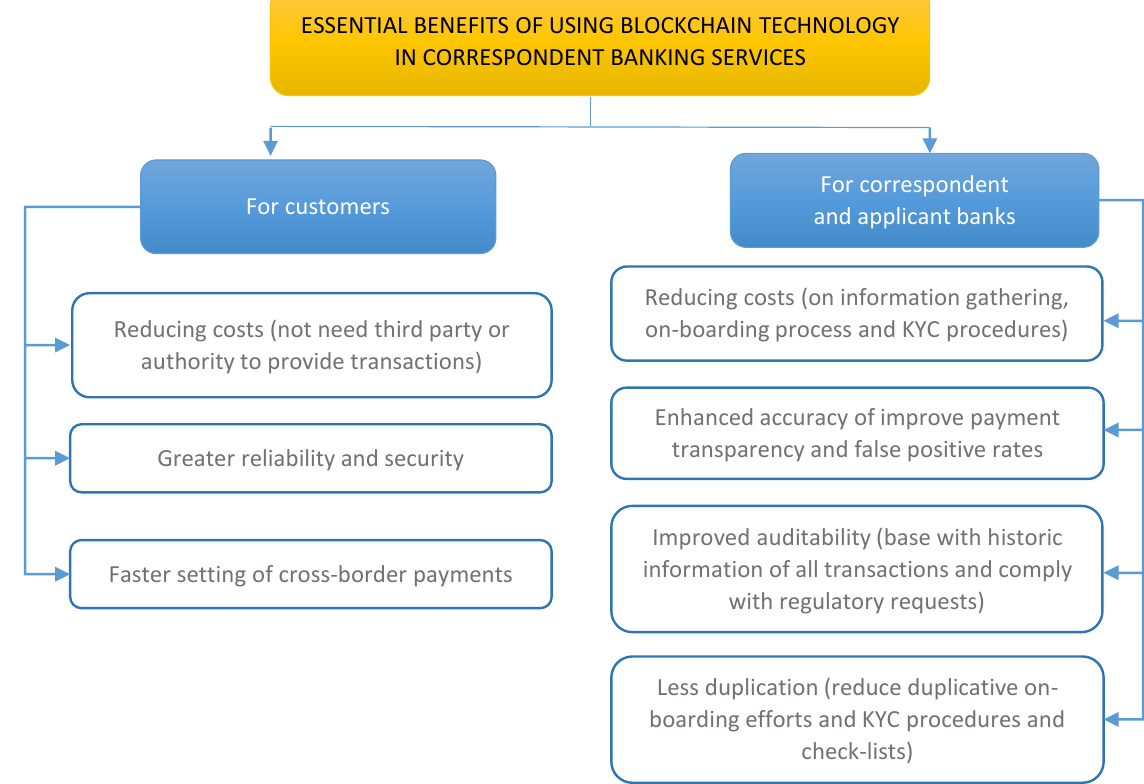
Figure 6. Essential Benefits of using blockchain technology in CBRs